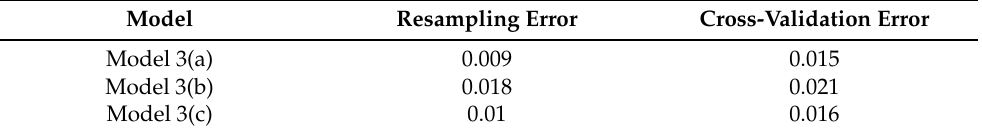
Figure 7. Model 3. From left to right are ( a ) the generated decision model, ( b ) the decision model with the least value for the leaf node, ( c ) the decision model after pruning. Table 3. The resampling error and cross-validation error values of decision model